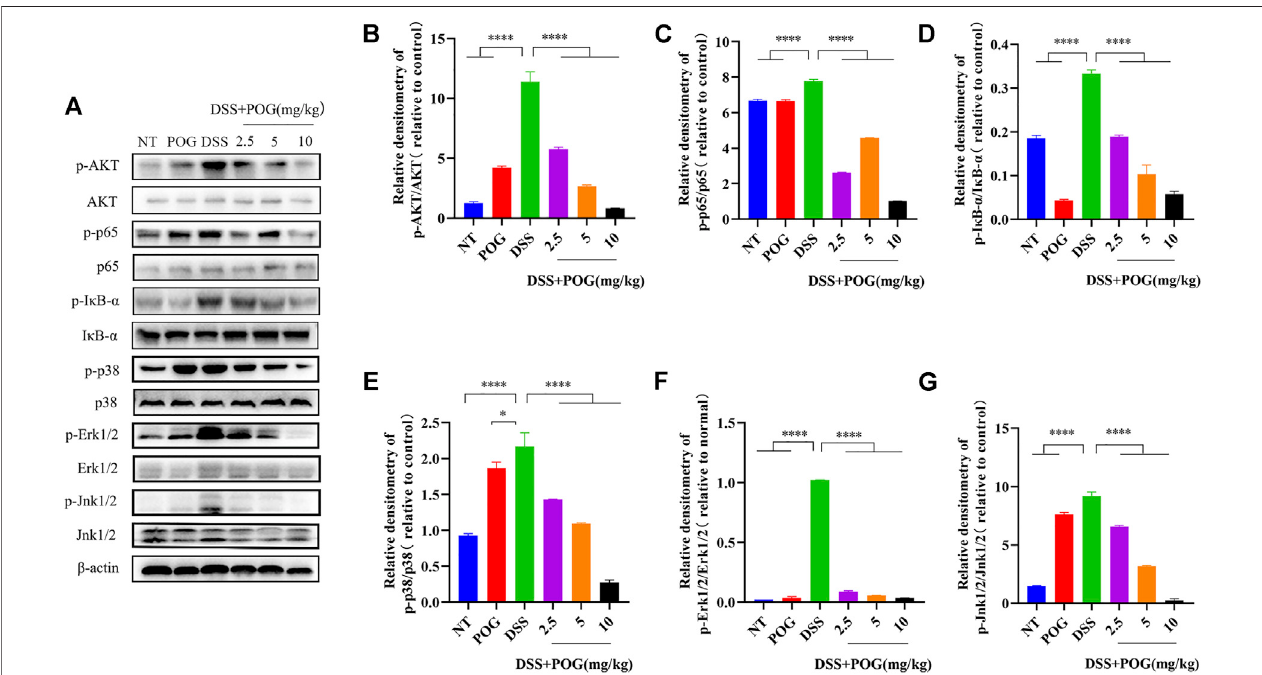
FIGURE 3 |(A) POG effectively controlled the expression of protein bands phosphorylated by AKT, NF- κ B, and MAPK signaling pathways in UC mice. (B – D) AKT, I κ B- α ,andp65 protein phosphorylation ofallgroupsweremeasured throughWBassay. (E – G) Thephosphorylation ofP38,ERK1/2,and JNK1/2intheMAPKpathway was evaluated by Western Blot. Data are means ± SD ( n = 3). * p < 0.05, ** p < 0.01, *** p < 0.001, **** p <